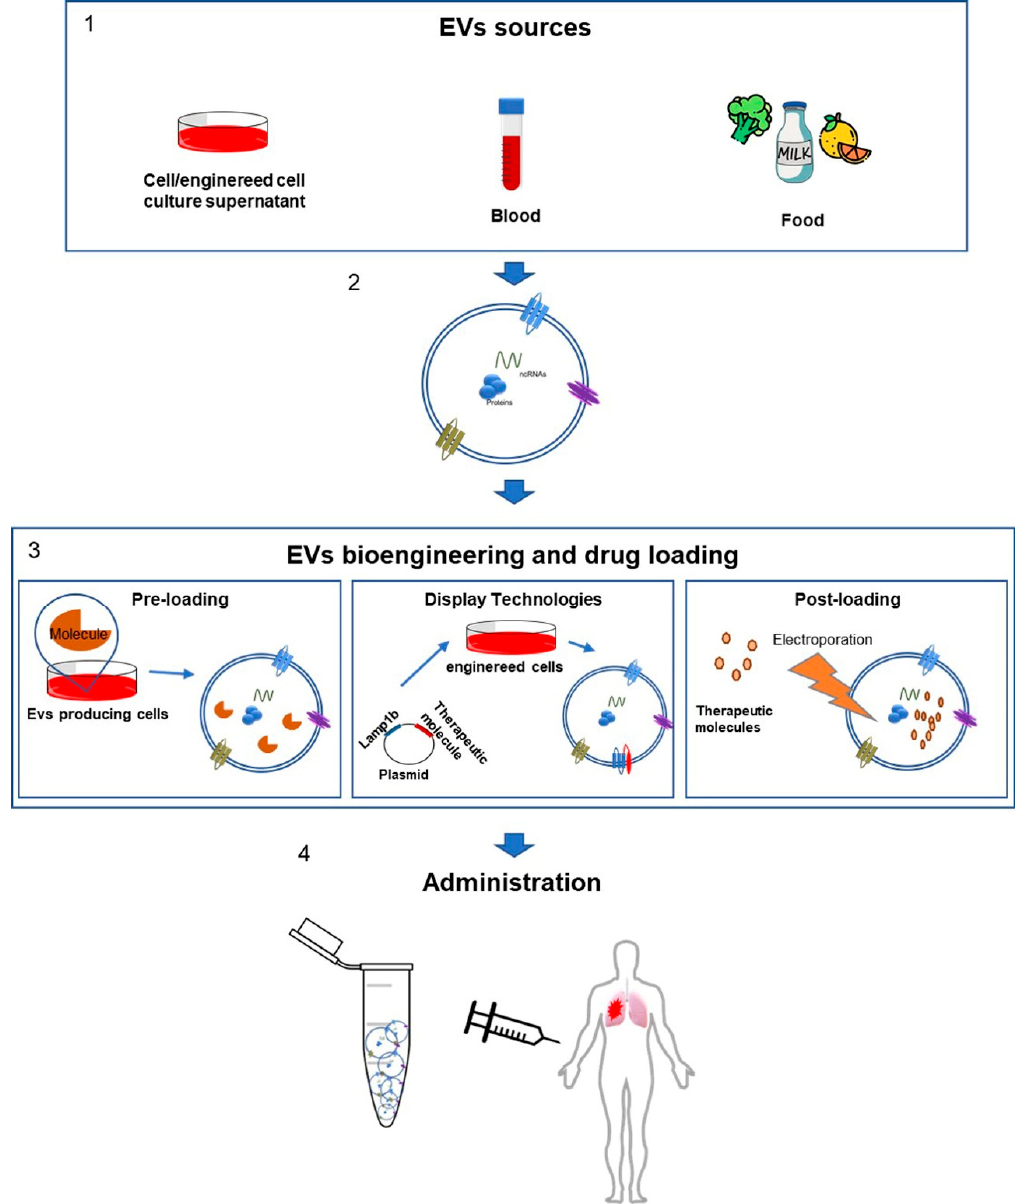
Figure 1. Strategy of EVs modification for therapeutic purposes. The figure schematizes the approaches currently used in EVs engineering or in the manipulation of their content. ( 1 ) The EVs are promising candidates in the treatment of numerous pathologies and there are various reliable sources. EVs can be isolated from the cell culture supernatant of various producing cell lines, from body fluids and also from food. ( 2 ) The EVs molecular composition is complex and it depends on the cellular source. They can contain different classes of proteins (membrane-bound tetraspanins CD9, CD81 and CD63; receptors, heat shock proteins), ncRNAs (RNAs; MicroRNAs) and lipids (lysobisphosphatidic acid; phosphatidylcholine; phosphatidylethanolamine and sphingomyelin). ( 3 ) The different methods to manipulate the EVs content include the preloading approach, in which a pre-existing endogenous cargo is the therapeutic molecule. In the display technology, the EV-producing cells can be engineered with a plasmid in order to induce the expression of exogenous proteins. The post-loading method consists in the direct introduction of drug molecules into EVs after their isolation. ( 4 ) The engineered EVs may also be manipulated to be more bioactive and bioavailable and can be administered to patients for the MPM therapy.